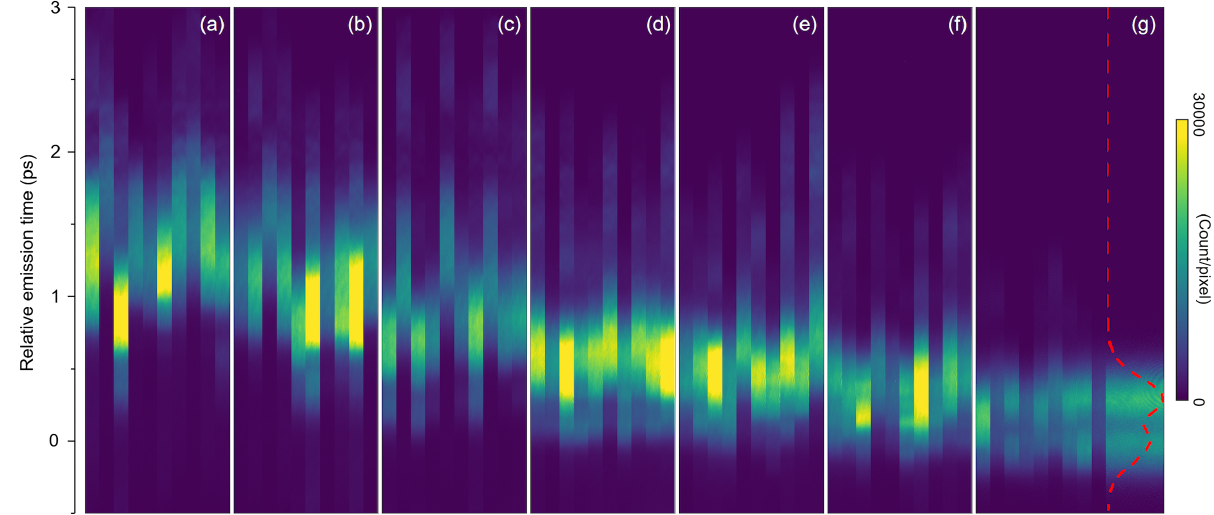
FIG. 2. Single shot EO signals from He. Single-shot EO signals at plasma densities of f 2 . 2 ; 2 . 4 ; 2 . 7 ; 2 . 9 ; 3 . 1 ; 3 . 5 ; 3 . 7 g × 10 19 cm − 3 from He gas are illustrated in (a-g), respectively. 10 consecutive shots of data are listed in each figure with a time range between − 0 . 5 ps and 3 ps. In (g), one of the figures was stretched in width for better visualization of the multibunch